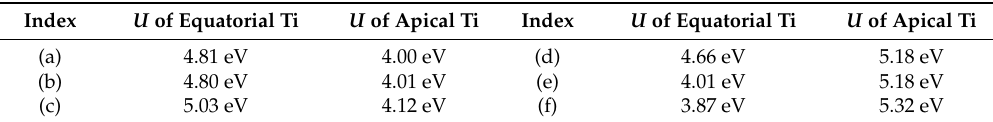
Table 2. Hubbard U parameter of polaronic configurations in Figure 3. All of the U values are calculated by linear response method. Index (a–c) for small polaronic configurations and (d–f) for mixed polaronic